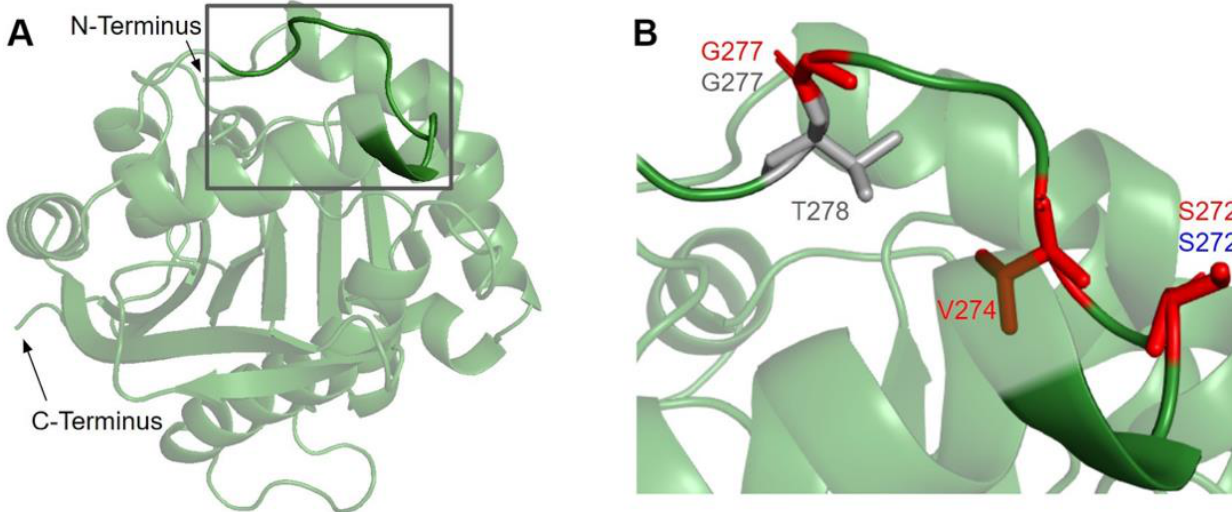
Figure 8. SNVs found in the membrane interacting hydrophobic region of COQ3. ( A ) Residues I270 to H279 are highlighted on residues 91 – 336 of the COQ3 model. N- and C-termini were truncated for simplicity. ( B ) Locations of SNVs in the hydrophobic region are depicted. Residues are colored according to their corresponding SNVs in Figure 3.